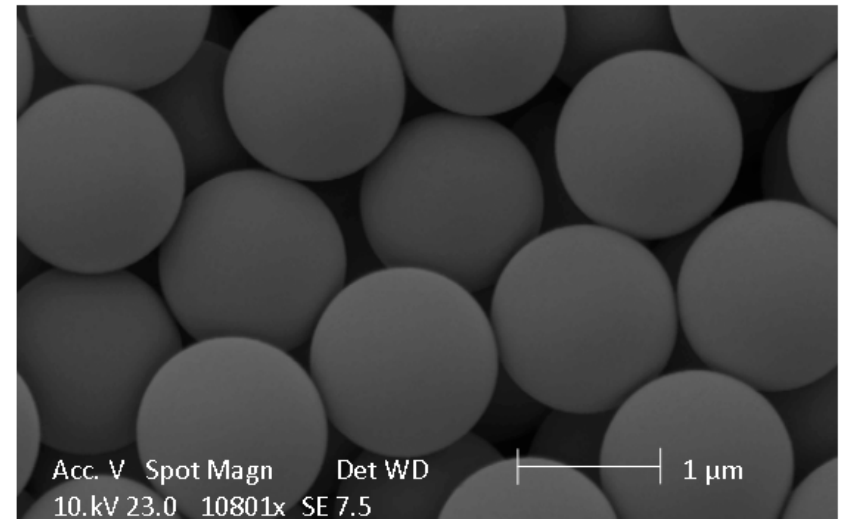
Figure 16. SEM images of 1 µm fl uorescent microspheres.